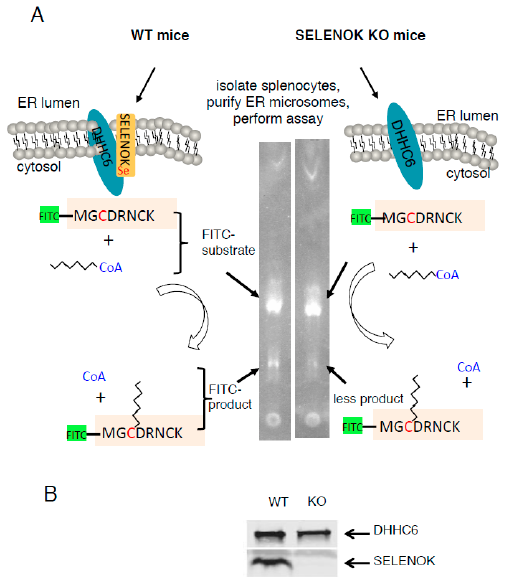
Figure 1. A diagram illustrating protocol for detecting palmitoylation of peptides by murine splenocyte microsomes. ( A ) Splenocytes were isolated from either WT or SELENOK mice, and microsomes were prepared containing ER membranes with or without SELENOK, respectively. Substrates including palmitoyl-CoA and FITC-peptide were added to microsomes for different periods of time after which the reaction mixtures were subjected to reverse-phase TLC. Fluorescent bands corresponding to palmitoylated peptides were identified using UV transillumination. ( B ) For each experiment, equivalent levels of DHHC6 were confirmed using Western